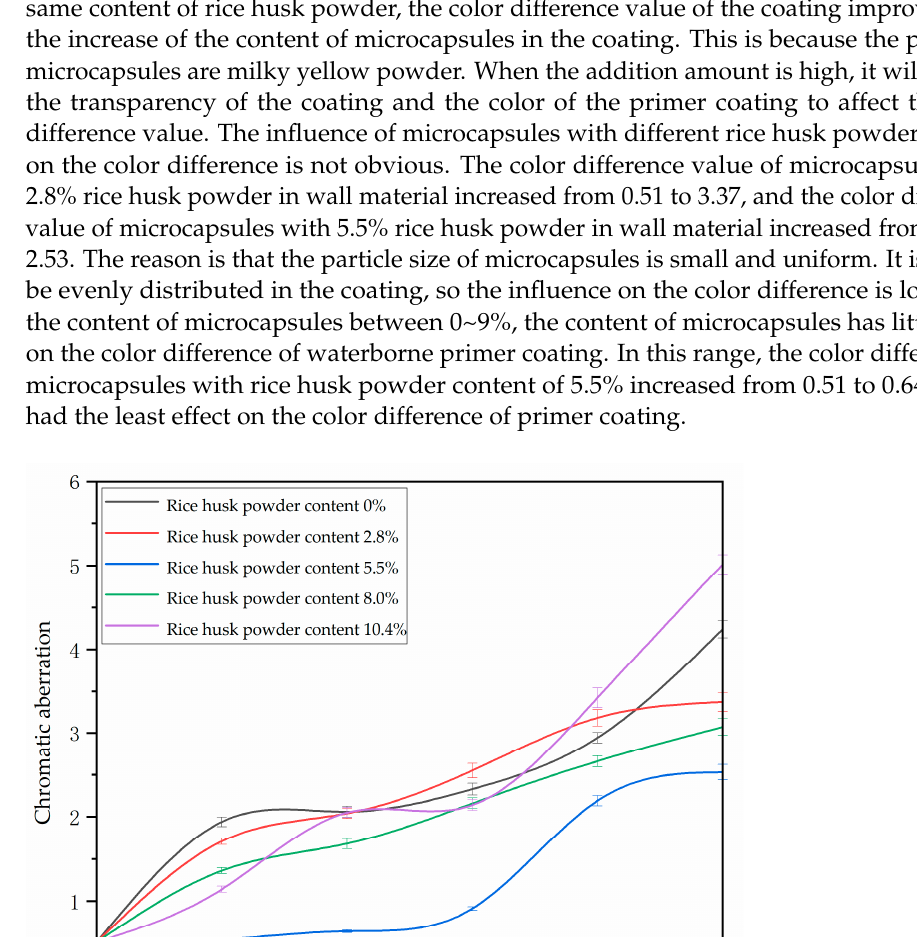
Figure 7. Effect of microcapsules with different wall material ratios on the gloss of waterborne pri- mer coating.